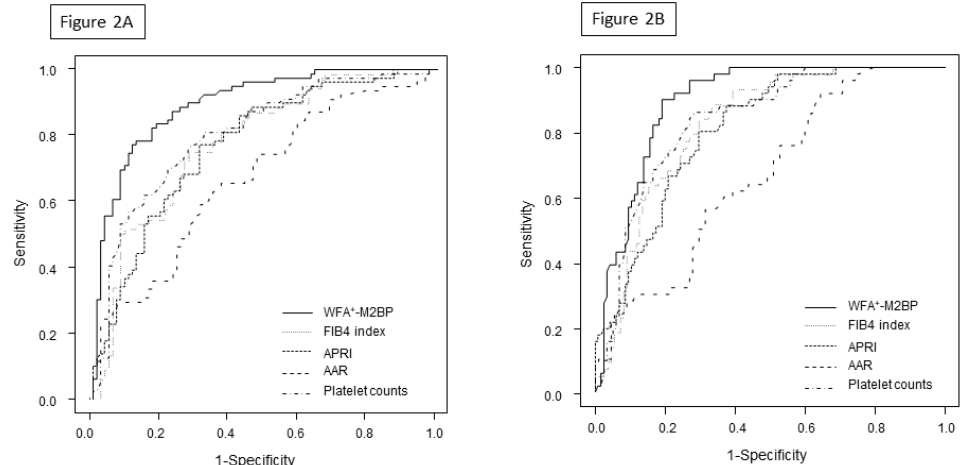
Figure 2. Receiver operating characteristic curves of WFA+–M2BP and other serum fibrosis markers. Various serum markers of fibrosis were compared to ensure the diagnostic accuracy of the presence of GEV ( A ) and the presence of large GEV ( B ).